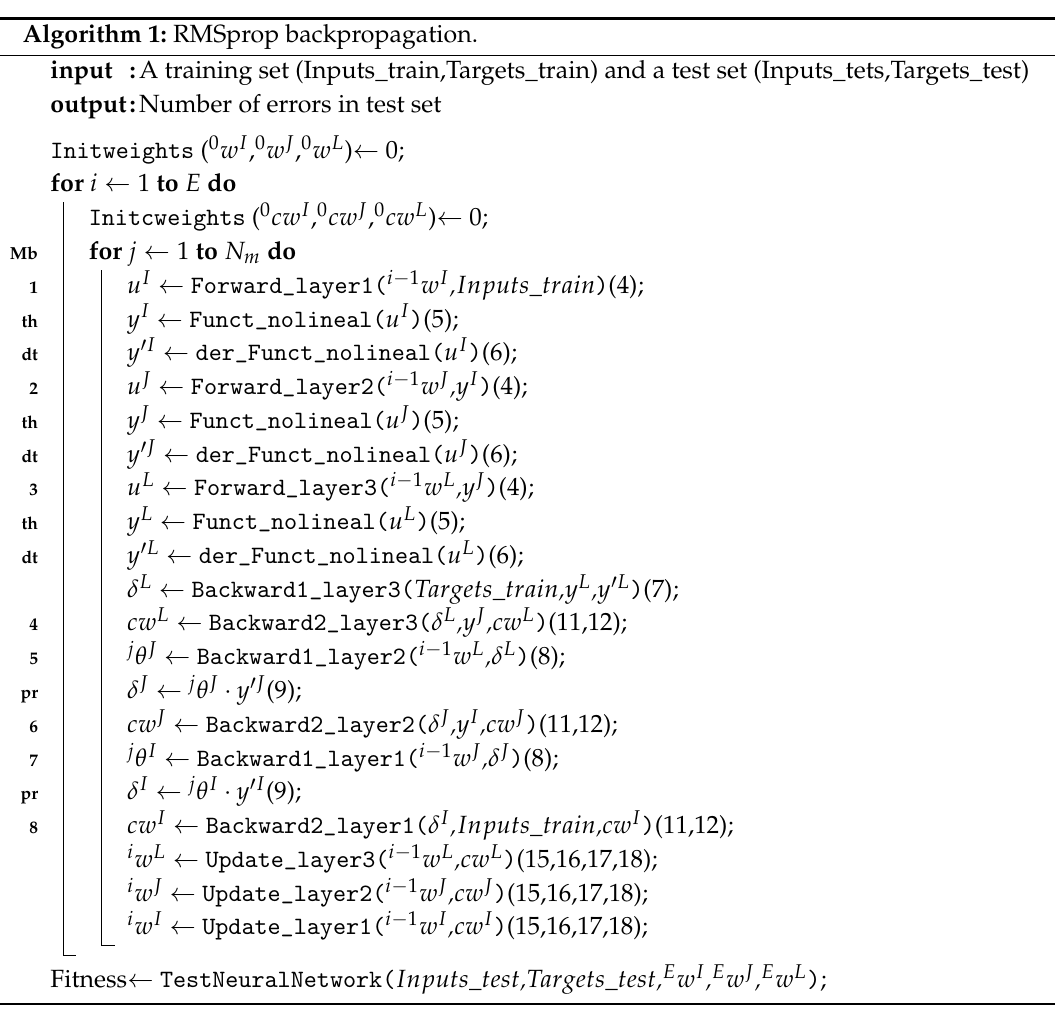
Algorithm 1: RMSprop